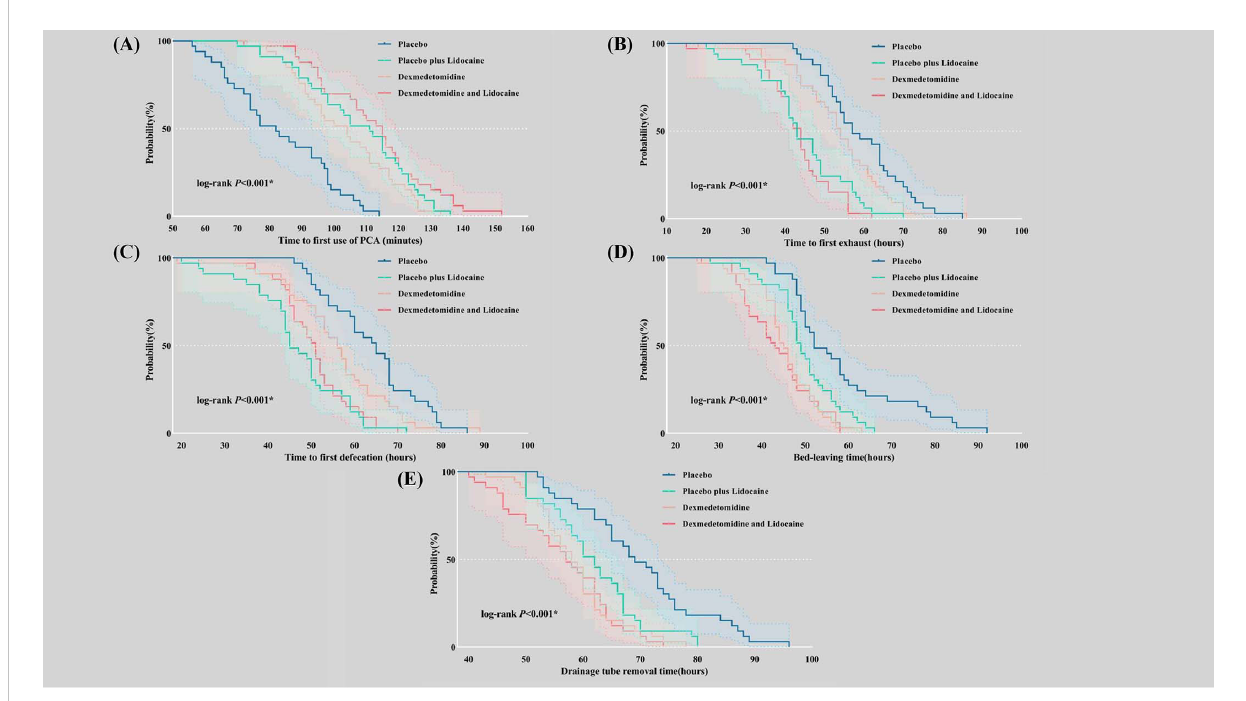
FIGURE 4 Kaplan − Meier curves were used to describe time-related outcomes during the postoperative period. (A) Time to fi rst use of PCA; (B) Time to fi rst exhaust; (C) Time to fi rst defecation; (D) Bed-leaving time; (E) Drainage tube removal time. PCA, patient-controlled